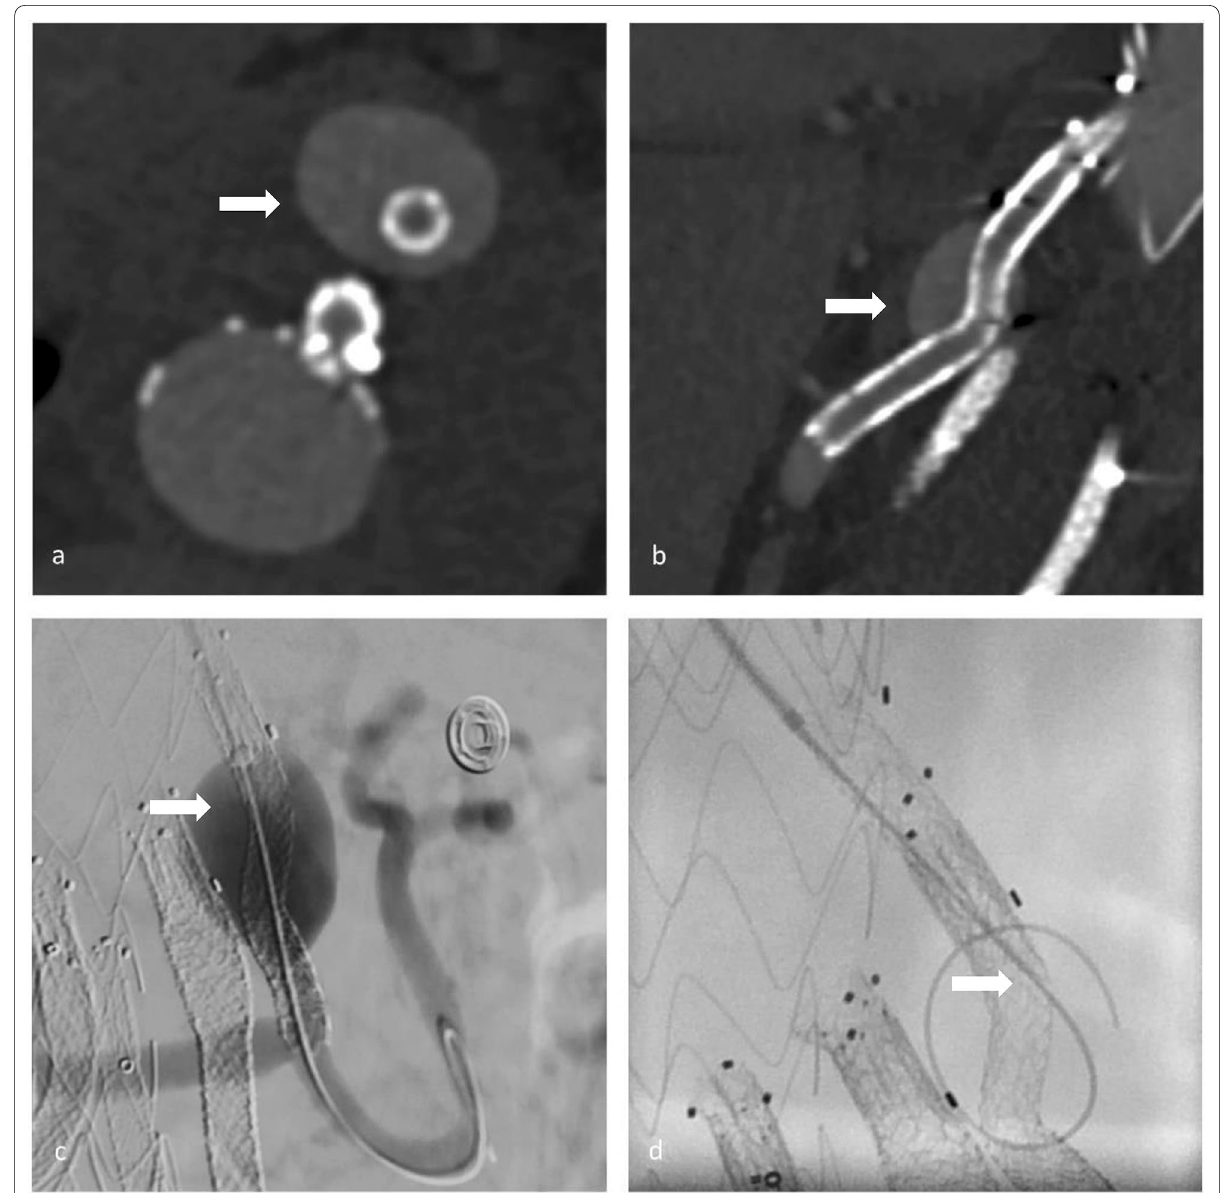
Fig. 3 Membrane disruption and wire fracture of BSG (failure mode 2) in celiac trunk with an endoleak surrounding the BSG in CTA ( a , b ) and angiography ( c ). Guide wire passage was possible through the fractured BSG into the aneurysm ( d